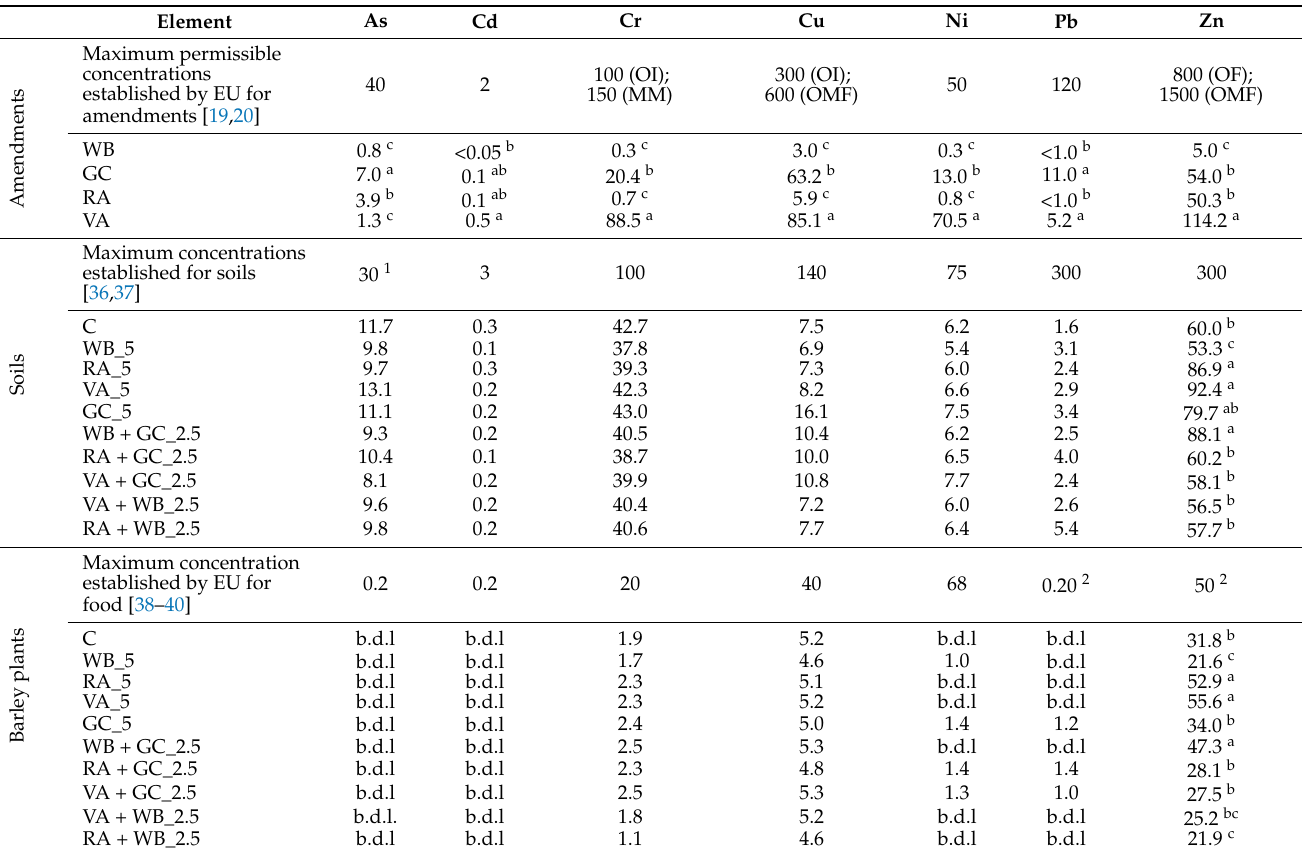
Table 2. Average measured concentrations and maximum permissible values of toxic elements in amendments, soils and barley (or plants in the absence thereof) in mg kg − 1